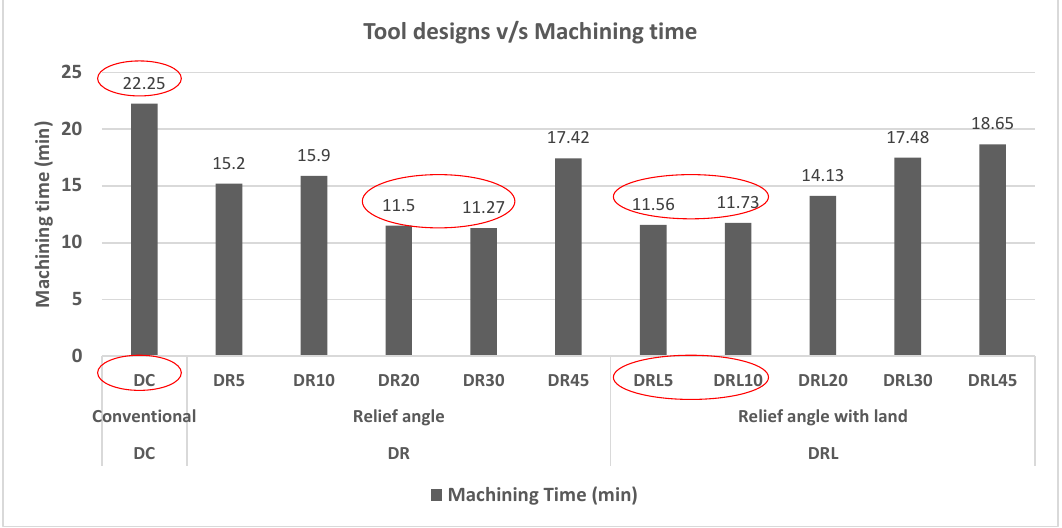
Figure 4. Effect of electrode designs on machining time. Figure 4. E ff ect of electrode designs on machining